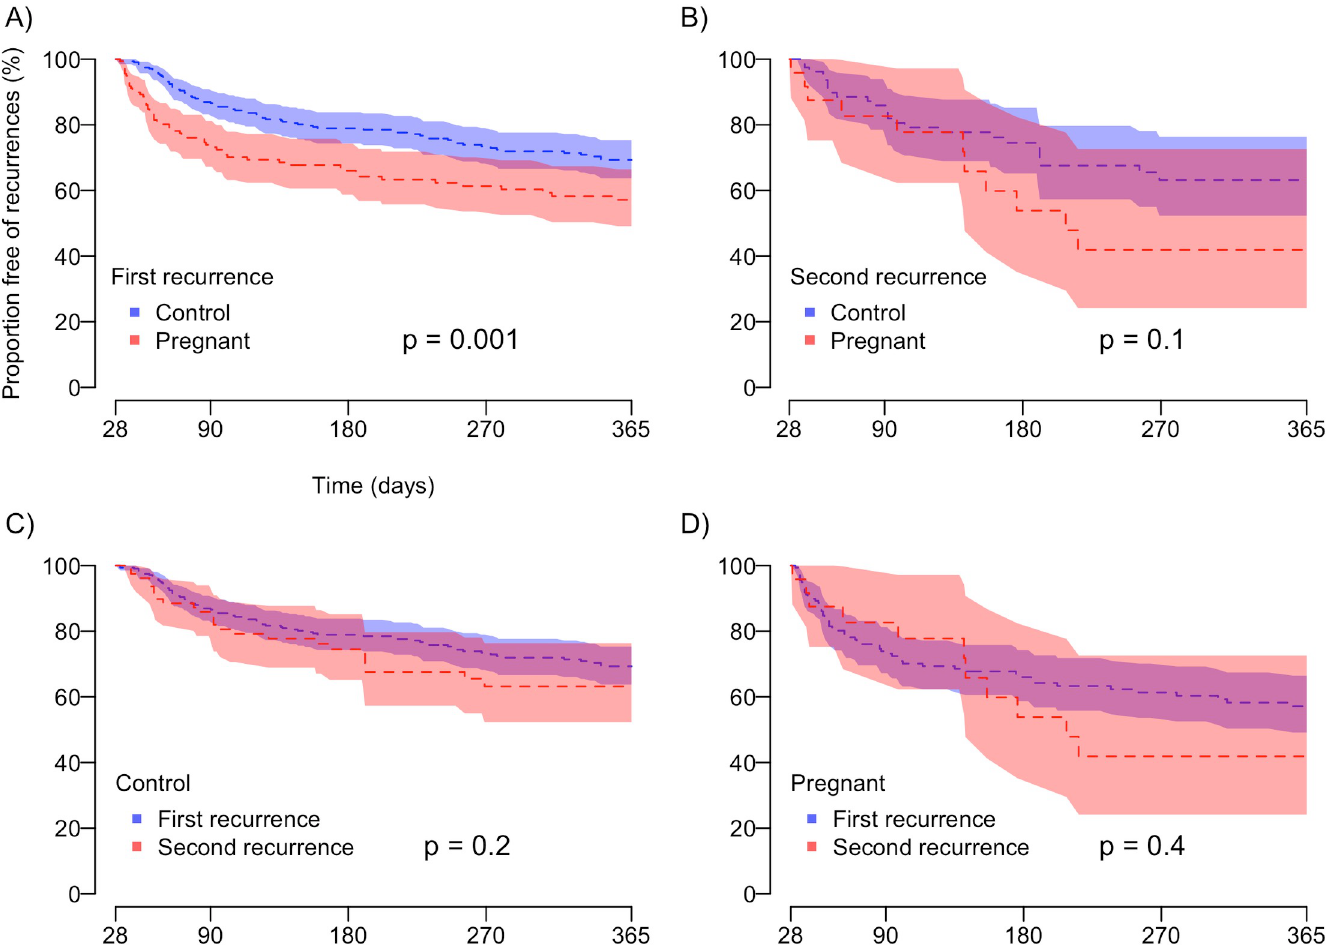
Fig 2. Time-to-recurrence over 12 months of follow-up in PQ-untreated pregnant women and PQ-treated non-pregnant control experiencing a primary vivax malaria episode. The shaded areas indicate the 95% confidence bands. PQ-untreated pregnant women were eligible for the second recurrence analysis if PQ was not given to treat the first episode. (A) Time to first vivax malaria recurrence, control vs. pregnant women; (B) Time to second vivax malaria recurrence, control vs. pregnant women; (C) Time to first recurrence vs. time to second recurrence, control women; (D) Time to first recurrence vs. time to second recurrence, pregnant